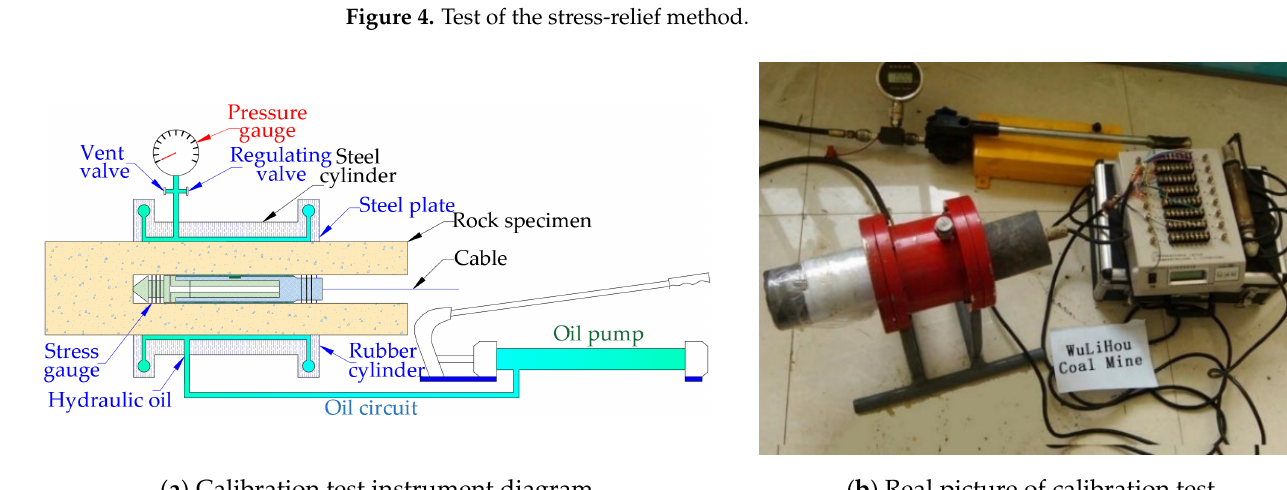
Figure 5. Calibration test instrument.